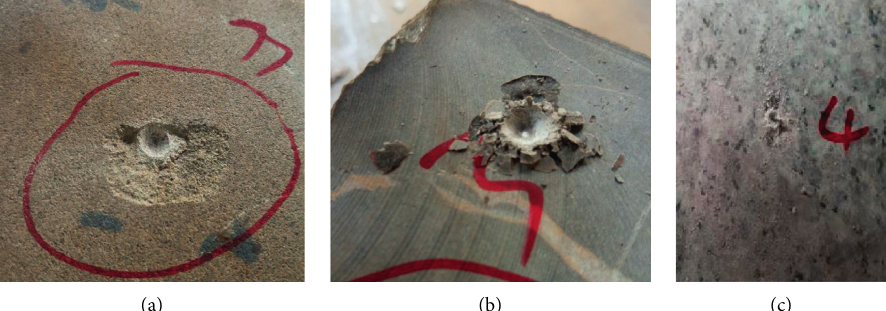
Figure 6: Breaking holes and debris of the flat samples and core columns under static-pressure breaking: (a) sandstone; (b) limestone; (c) granite (reproduced from [14]).